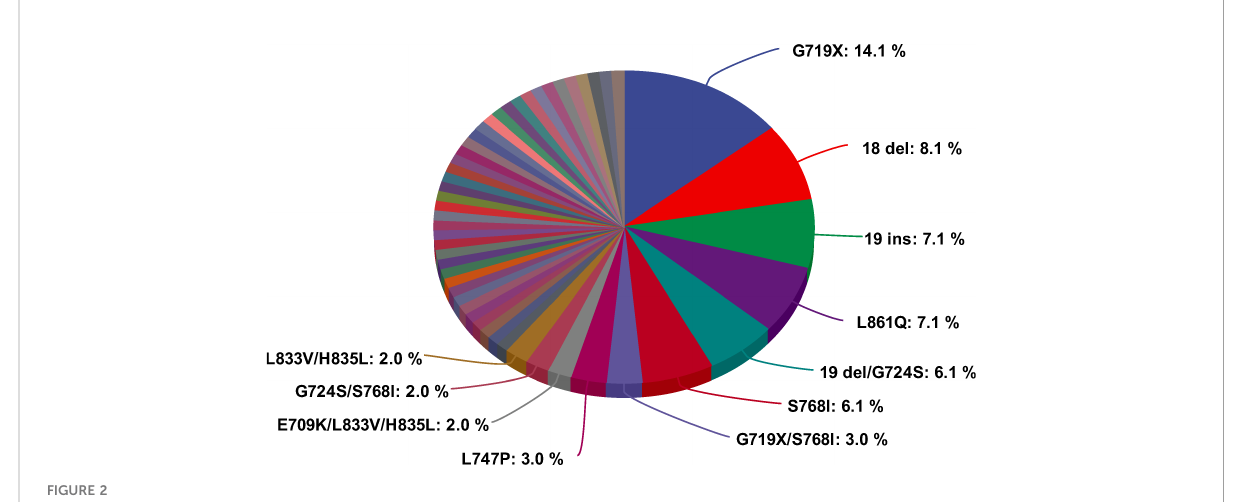
FIGURE 2 Composition of un-common EGFR mutations